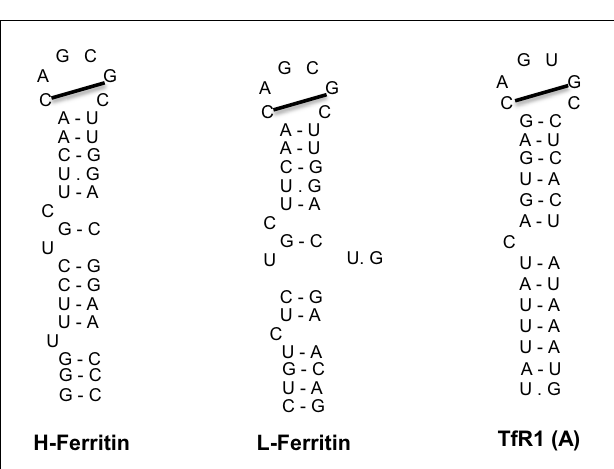
FIGURE 3 | IRE motifs in the untranslated regions of the mRNAs encoding human H-ferritin, L-ferritin and TfR1 (only the A IRE of TfR1 mRNA is shown). Watson-Crick base pairing is depicted by a dash and non-Watson-Crick interactions by a dot. The line connecting the 1st and 5th nucleotide of the IRE loop indicates Watson-Crick base